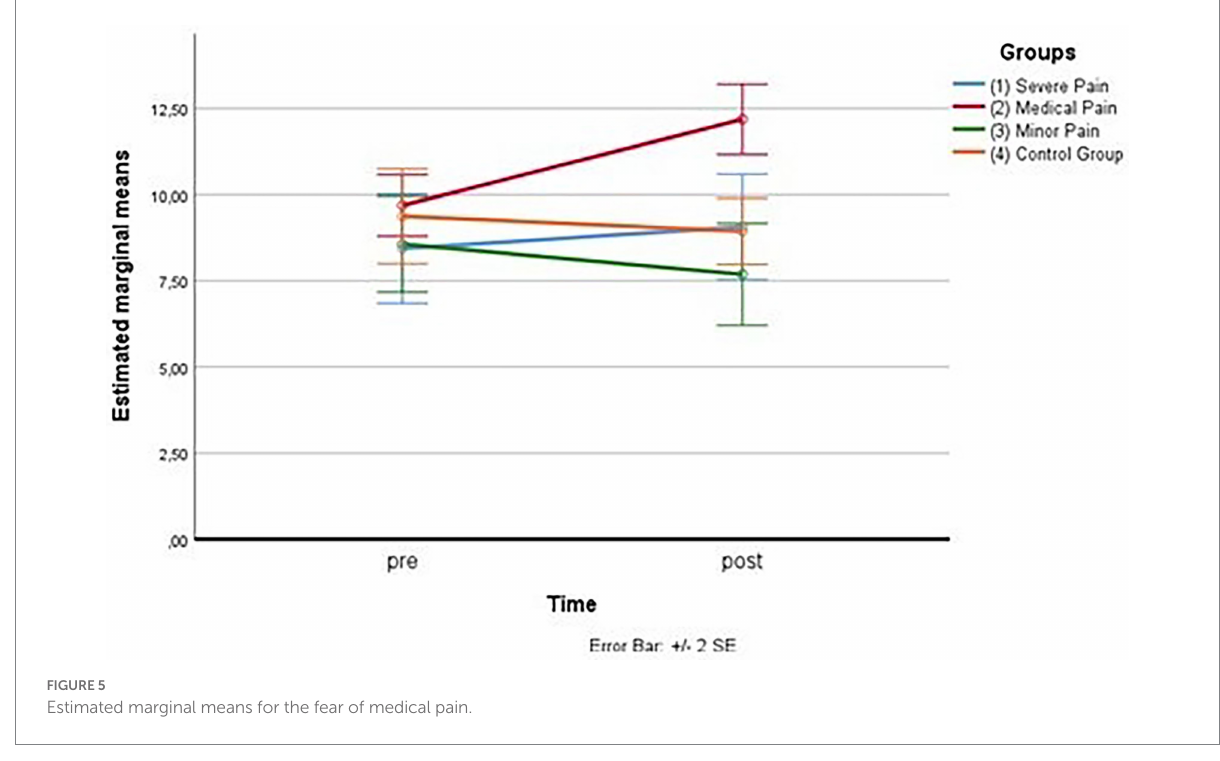
FIGURE 5 Estimated marginal means for the fear of medical pain.